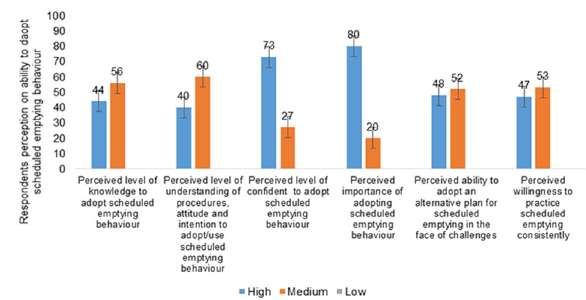
Fig. 7 Respondents ’ perception on their ability to adopt scheduled emptying (timely and safely) behaviour for onsite sanitation systems/ non-sewered sanitation systems (OSS/NSS) in the study area. Members of 400 households were surveyed via a structured questionnaires on how they perceived their individual and household ability to carried out scheduled emptying (i.e., timely and safely) of onsite sanitation systems/ non-sewered sanitation systems (OSS/NSS) in their community. Perceived level of required knowledge to practice scheduled emptying was high (44%) and medium (56%); perceived level of understanding for all